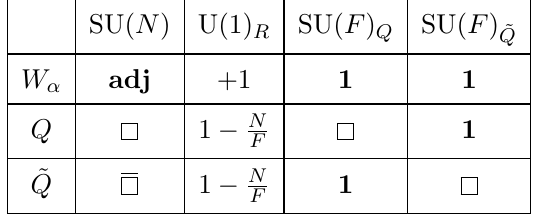
Table 1 . Quantum numbers of fields in the electric SU( N ) SQCD.